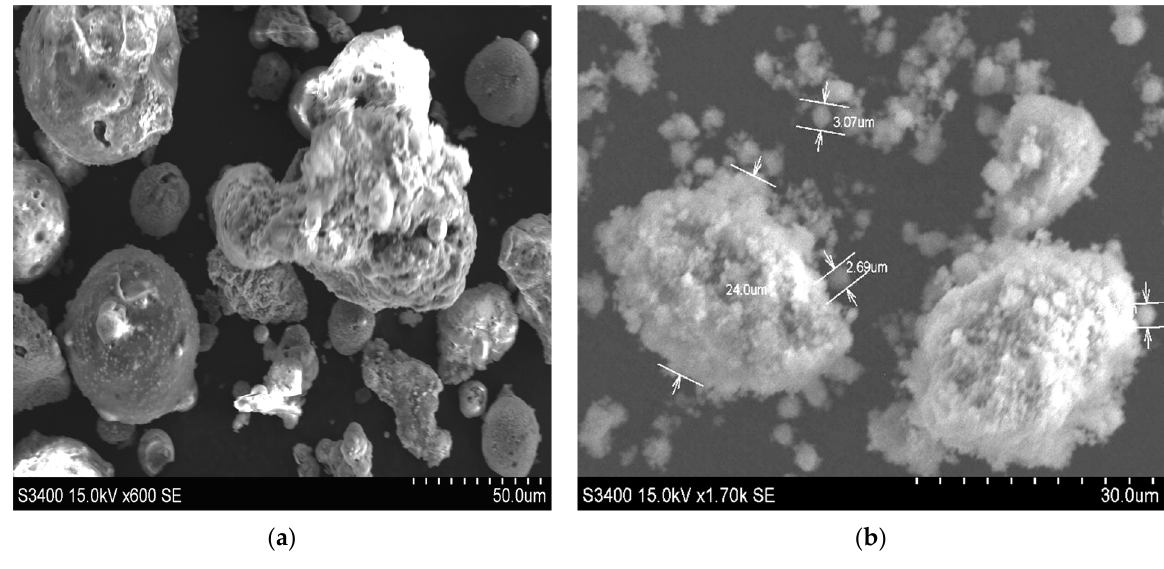
Figure 5. SEM images of ( a ) FAw; ( b ) FADPt.